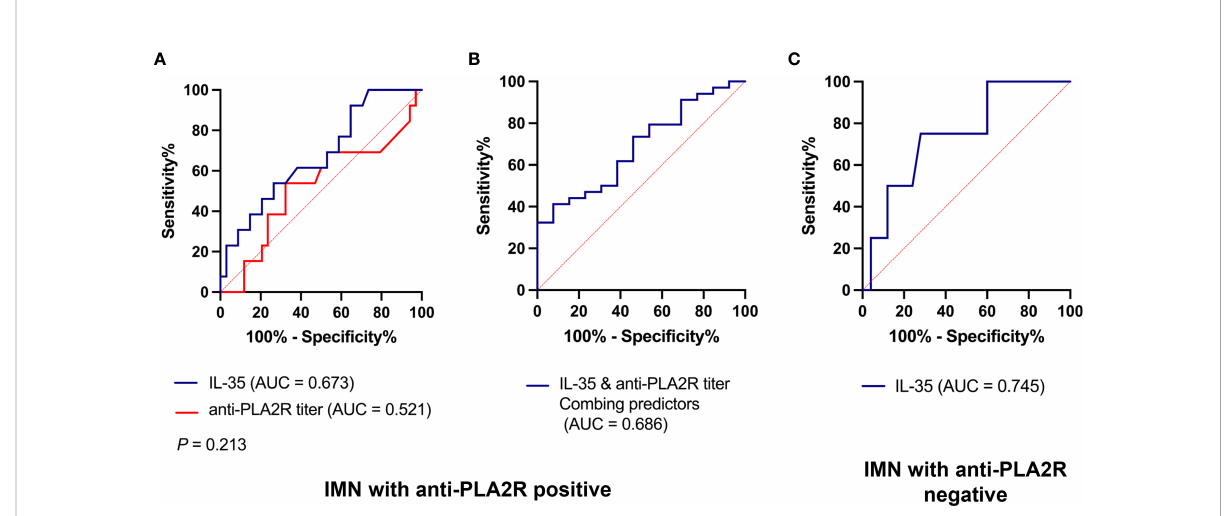
FIGURE 5 Area under the ROC curve for prediction of IMN remission. ROC compares the predictive value of IL-35 and/or aPLA2R titer in patients with IMN. (A) the predictive value of IL-35 or aPLA2R in IMN patients with positive aPLA2R; (B) the predictive value of IL-35 combined with aPLA2R titer in IMN patients with positive aPLA2R; (C) the predictive value of IL-35 in IMN patients with negative